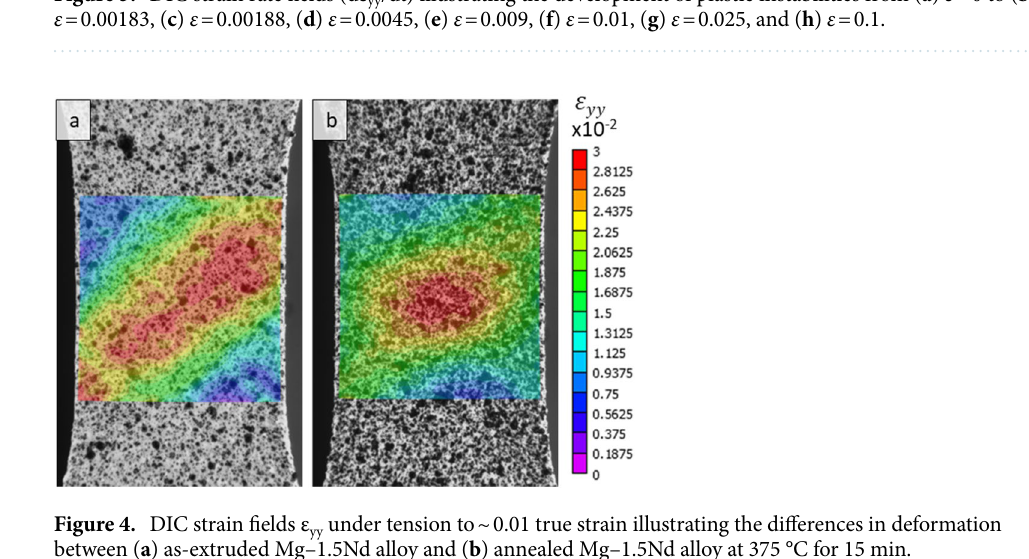
of 0.0125. In Fig. 5a, the red curve corresponds to the first fully reversed cycle and the red letters b-e correspond to the DIC strain fields presented in Fig. 5b–e. The black curves in Fig. 5a correspond to subsequent cycles. The yield plateau appeared in both the first forward tension and the first reversed compression loadings, after which it disappeared. The annealed material shows no such plateau. The deformation band appeared at the lower part of the gauge section and propagated toward the other end, reaching a local maximum of ~ 0.02 tensile ε yy strain (Fig. 5c,h). The band progressively faded during the unload- ing process to the point where it completely vanished (Fig. 5d). Upon the compression loading, a new compressive band formed in the top part of the sample reaching a similar local maximum of − 0.02 ε yy strain (Fig. 5e,i). The alternating appearance of the tensile and compressive deformation bands during the following cyclic loadings repeated in a similar pattern (Fig. 5f,g), but the extent of such plastic instability was progressively waning. After